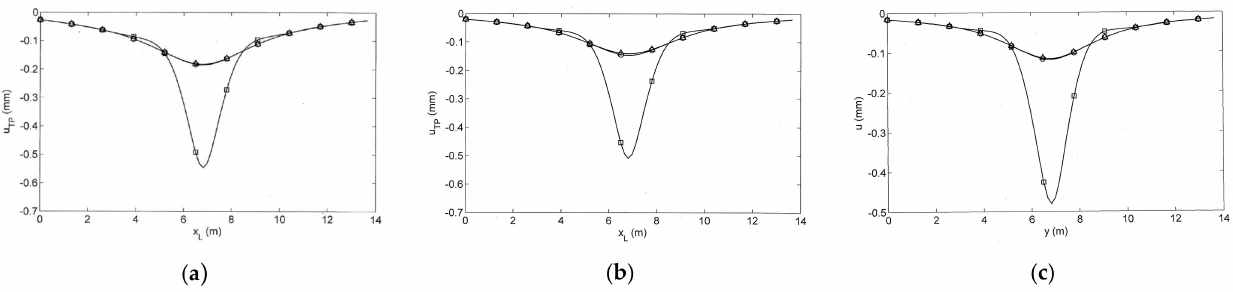
Figure 8. Calculated distributions of the slab track displacements for different soils of v S = ( a ) 150, ( b ) 175, and ( c ) 200 m/s; rail, track plate ≈ (cid:52) base layer, (FEBEM (cid:50) (cid:35)